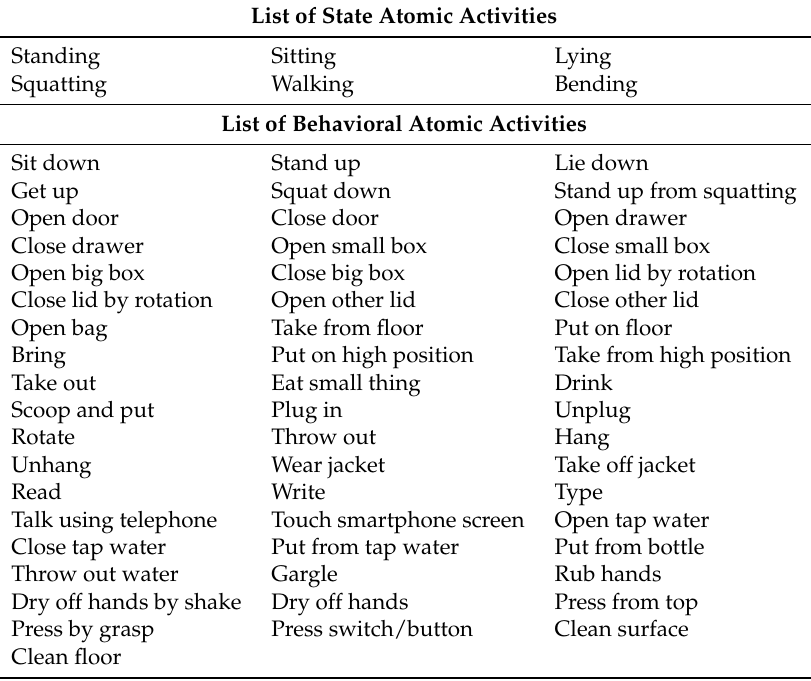
Table A1. List of state and behavioral atomic activities. List of State Atomic